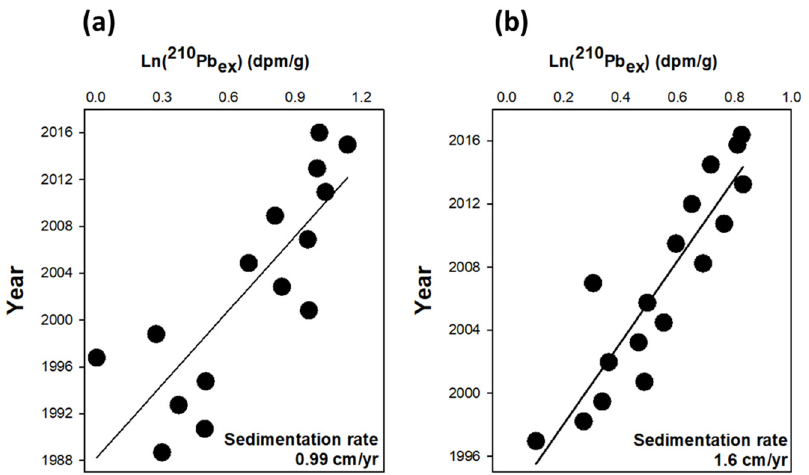
Figure 3. Sedimentation rates of the unused saltern ( a ) and the southern tidal flat ( b ) on Yubu Island in the western coastal area of the Yellow Sea in South Korea.